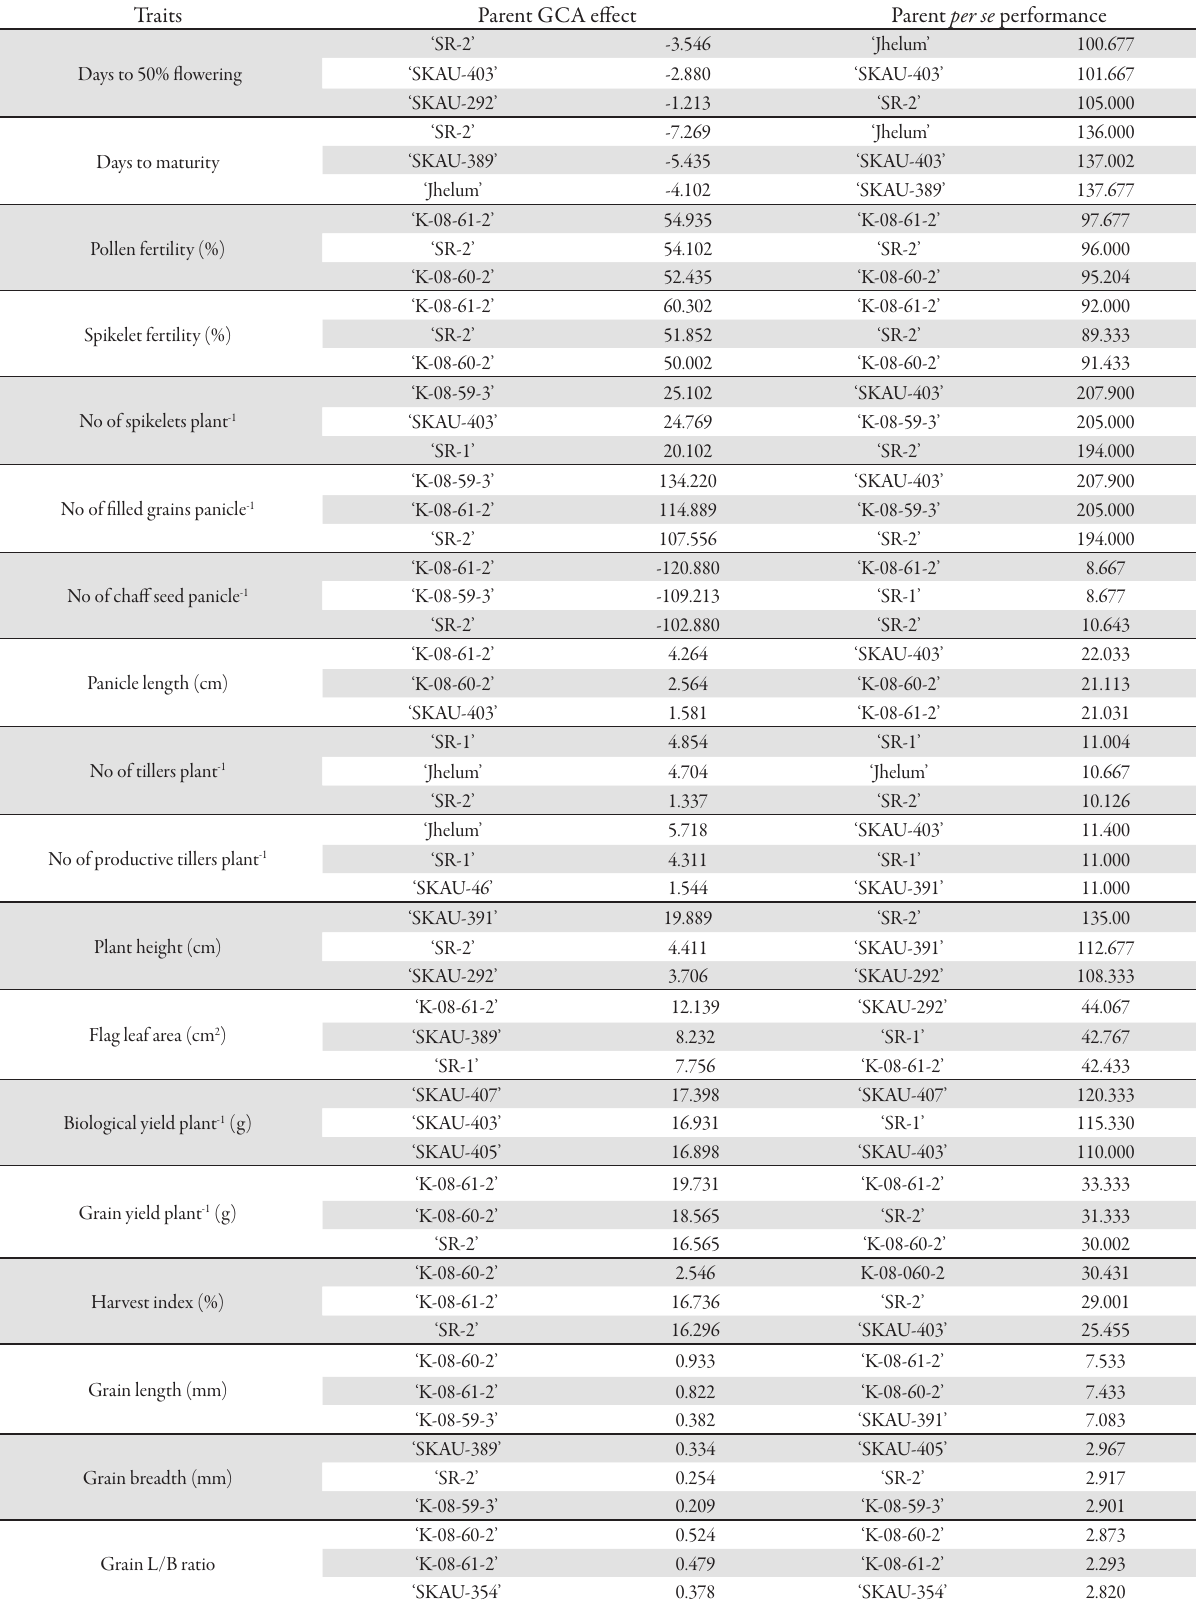
Tab. 5. Best parents identified on the basis of GCA and per se performance for different traits in rice Traits Parent GCA effect Parent per se